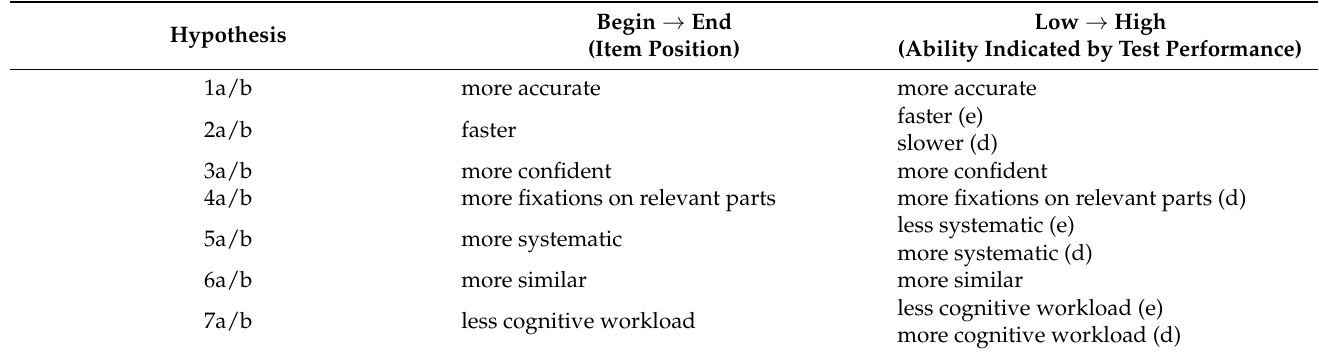
Table 1. Hypotheses for each independent variable and differentiated between difficulty